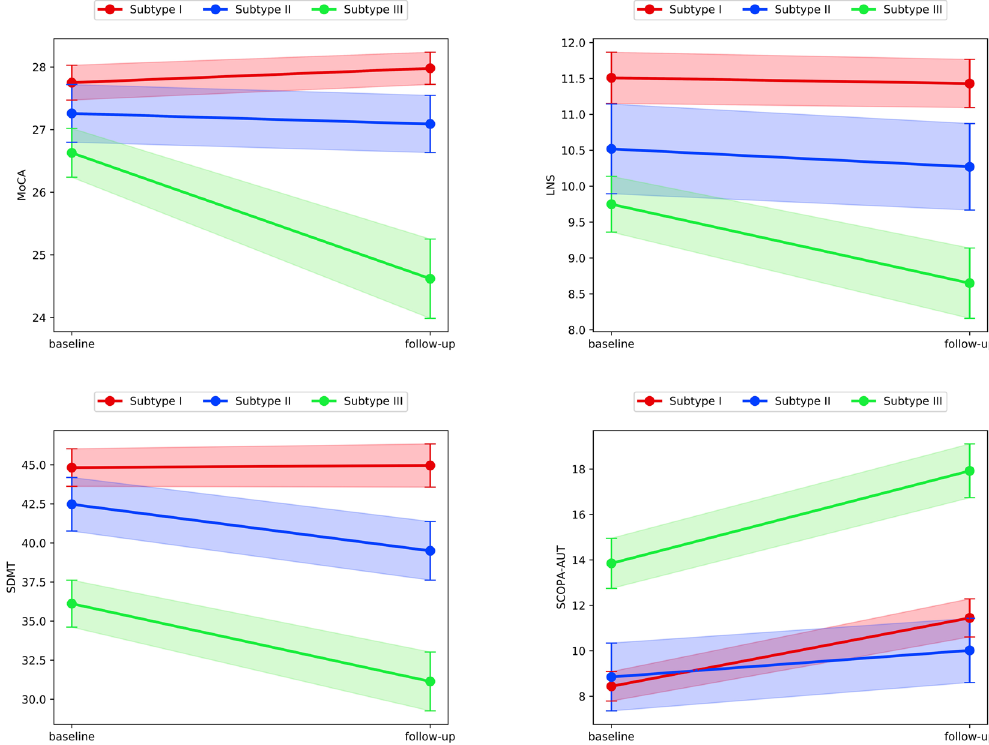
Figure 5. Comparisons of three Subtypes on disease progression of the variable MoCA, LNS, SDMT, and SCOPA-AUT. The time interval between baseline and follow-up is 6 years. The larger slope illustrates a more rapid progression on the corresponding variables. The filled regions indicate 95% Confidence Intervals as error bars for corresponding point estimates. Variables with the p-value < 0.05 are